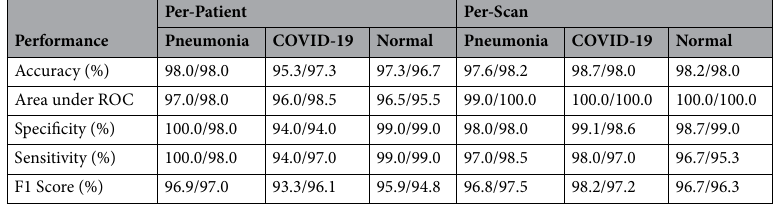
Table 1. Per-Patient Validation/Test